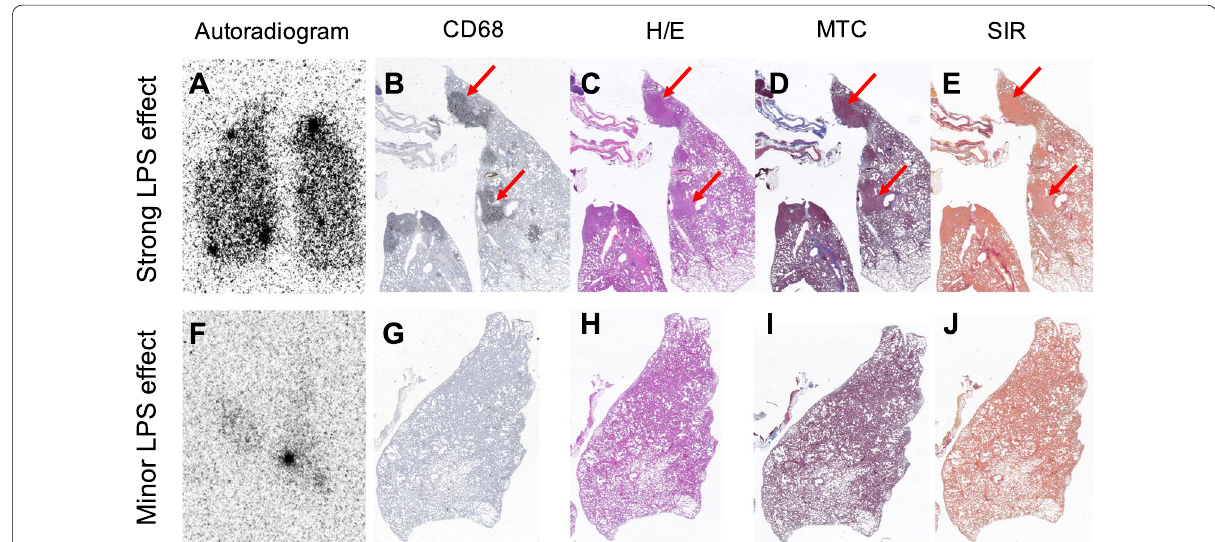
Fig. 2 Ex vivo autoradiography uptake of [ 68 Ga]Ga‑DOTA‑TATE and in lungs from rat with strong lung injury ( A ) and infiltration of CD68 macrophages ( B ) as verified by biopsy histology (C‑E), as well as a rat with minor lung injury free of macrophages ( F–J ). The abbreviations + for the stainings are as follows: Hematoxylin/ Eosin (H/E), Massons Trichrome (MTC), Sirius Red (SIR)